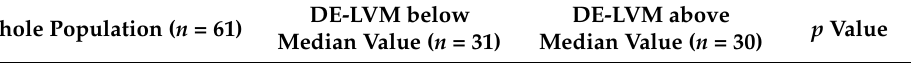
Table 3. Descriptive analysis of our population of patients with acute myocarditis and preserved ejection fraction, divided into two groups (above or below median value of left ventricular mass with delayed enhancement). Significant p values are reported in